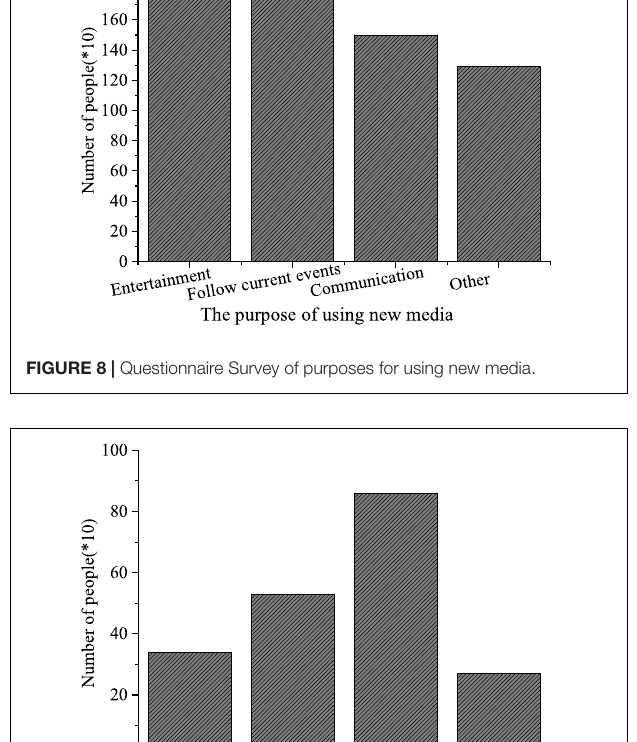
show that over 50% of the respondents use new media for at least 5 h